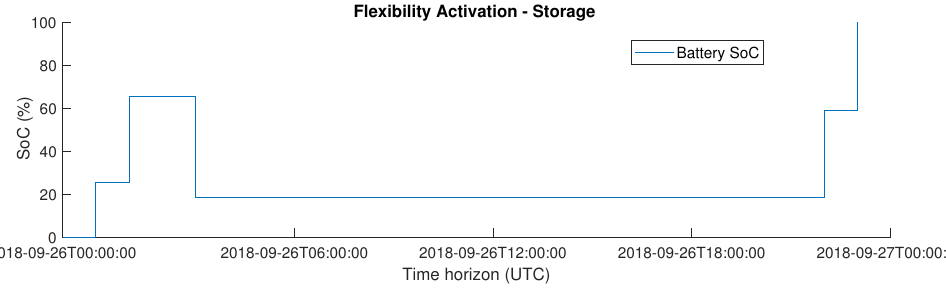
Figure 5. State of charge of the storage system.